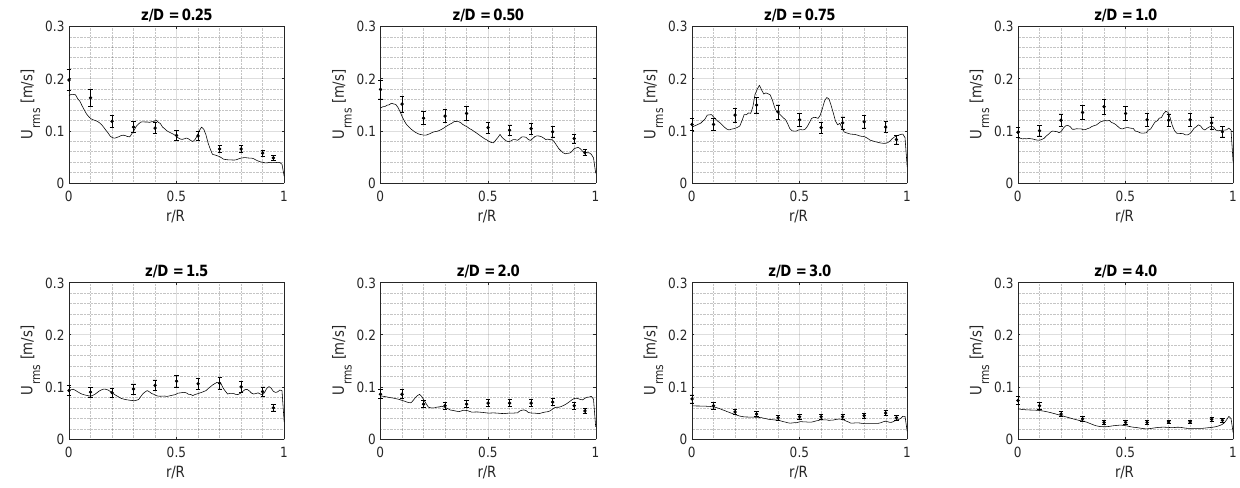
The 15th OpenFOAM Workshop (OFW15), June 22-25, 2020, Washington DC, USA Figure 12. RMS of tangential velocity at several cross sections (solid line: WALE LES, dots: experiments).